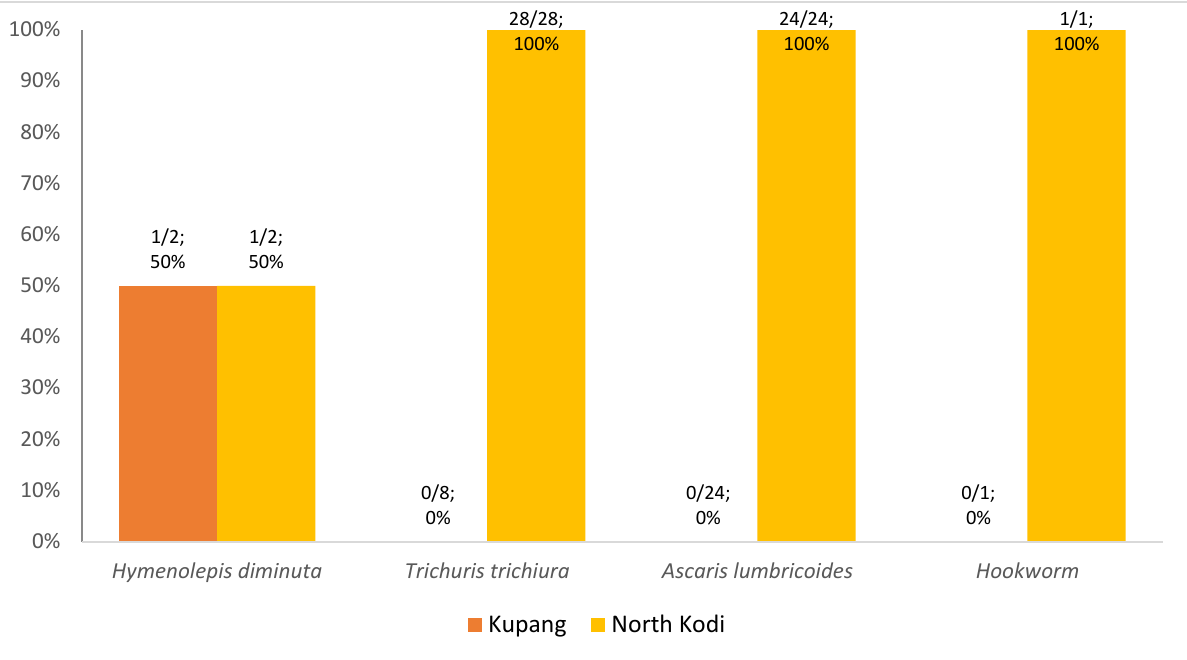
Figure 3. Intestinal helminthic distribution in Kupang and North Kodi, East Nusa Tenggara; n = 51 children. Hymenolepis diminuta was detected in a total of 2 children; Trichuris trichiura was detected in a total of 28 children; Ascaris lumbricoides was detected in a total of 24 children; Hookworm was detected in a total of 1 child (one child had ≥ 1 helminthic parasites).